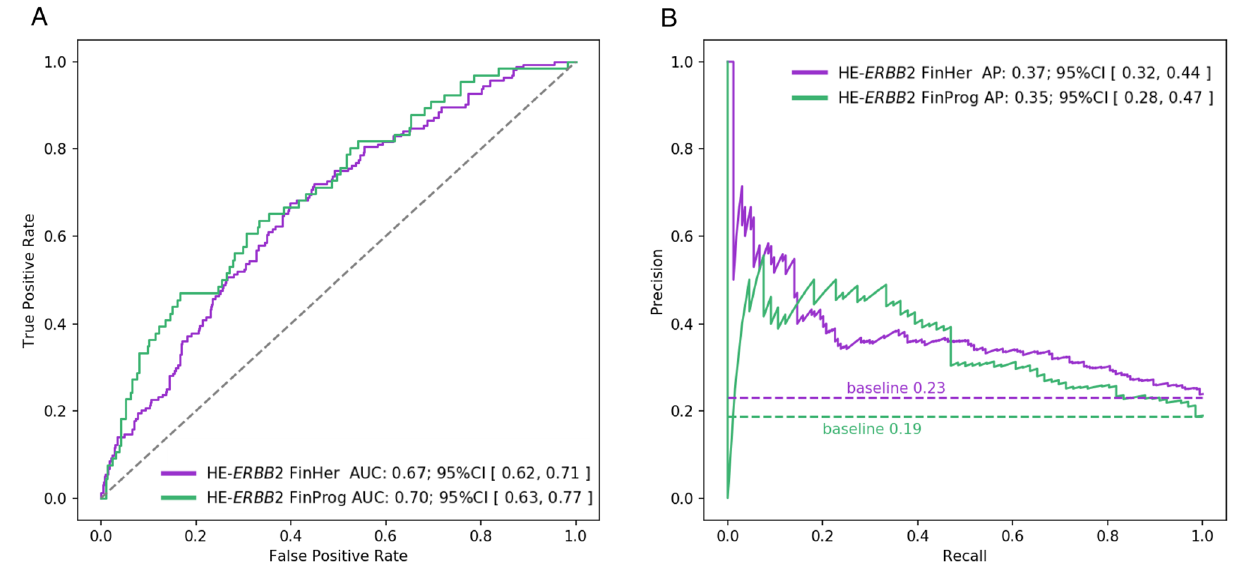
Figure 2. The H&E- ERBB2 score is a significant predictor of tumor ERBB2 gene amplification as determined by chromogenic in situ hybridization. The accuracy of neural network-mediated prediction of breast cancer ERBB2 status was evaluated with ( A ) receiver operating characteristic (ROC) curves and ( B ) precision-recall curves (PRC). The results are presented for both the internal (FinProg) and the external (FinHer) test sets. Area under the ROC curve (AUC) and average precision (AP) were calculated with 90% confidence intervals. The PRC curves were compared to the baseline precision, i.e. precision of a random classifier. The baseline is the ratio of ERBB2 -positive samples over the total number of ERBB2 -positive and ERBB2 -negative samples as determined by chromogenic in situ